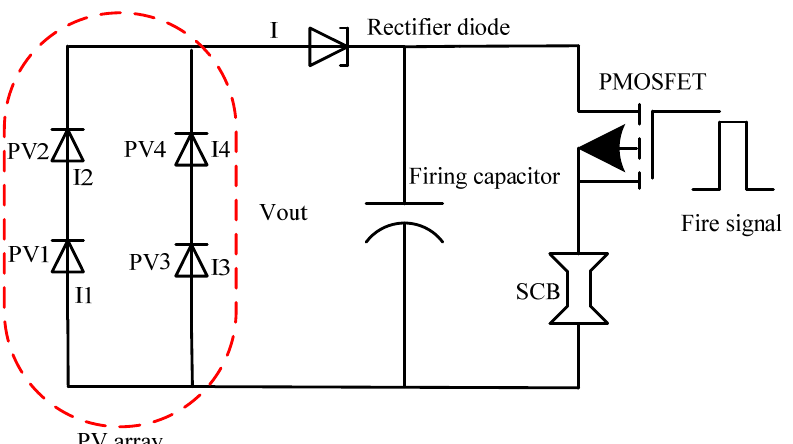
Figure 9. Laser storage and fire circuit of LCEID. Annotation: each PV consists of ten-junction vertically-stacked GaAs cells, as in reference [21].